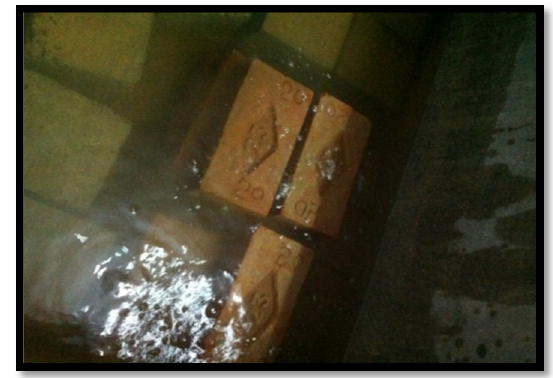
Fig. 9: Bricks submerged in